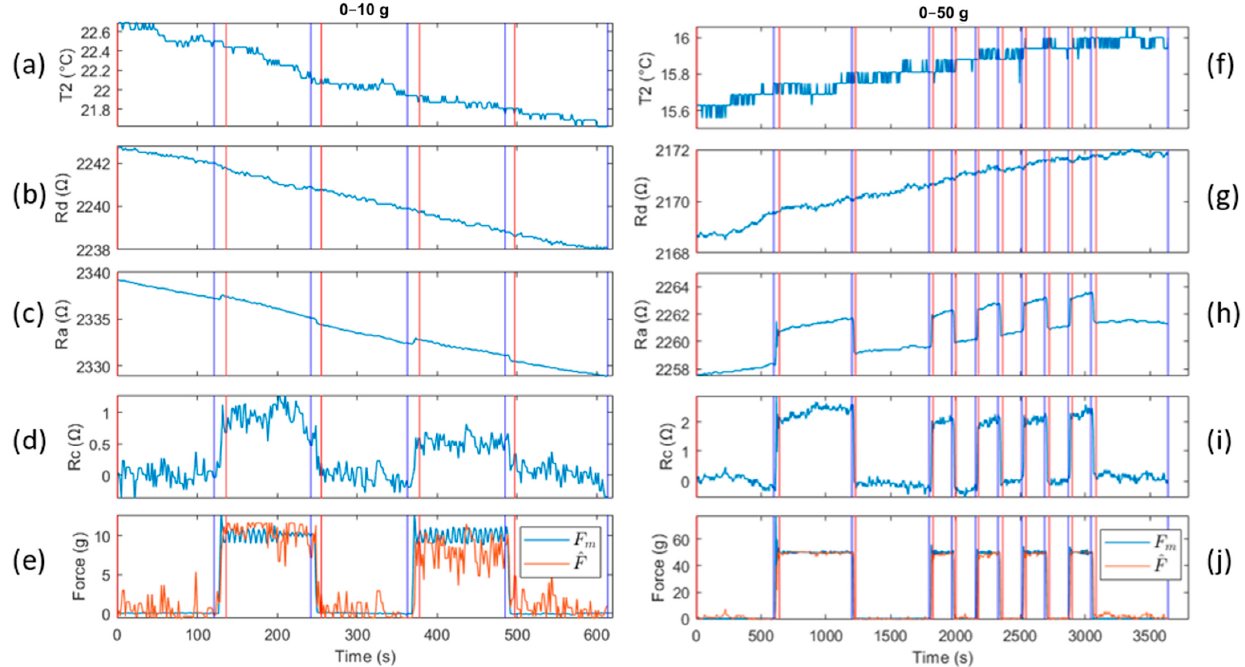
Figure 4. Preliminary on-off tests PF1 and PF2. From top to bottom: the digital temperature sensor ( T 2 ), the resistance of the dummy sensor ( R d ), the resistance of the sensor under test before ( R a ) and after ( R c ) compensation, and measured ( F m ) and fitted ( ˆ F ) force. Each label’s beginning and end are a red and a blue vertical line, respectively. The 0–10 g test PF1 ( a – e ) has 5 labels, whereas the 0–50 g test PF2 ( f – j ) has 11 labels.